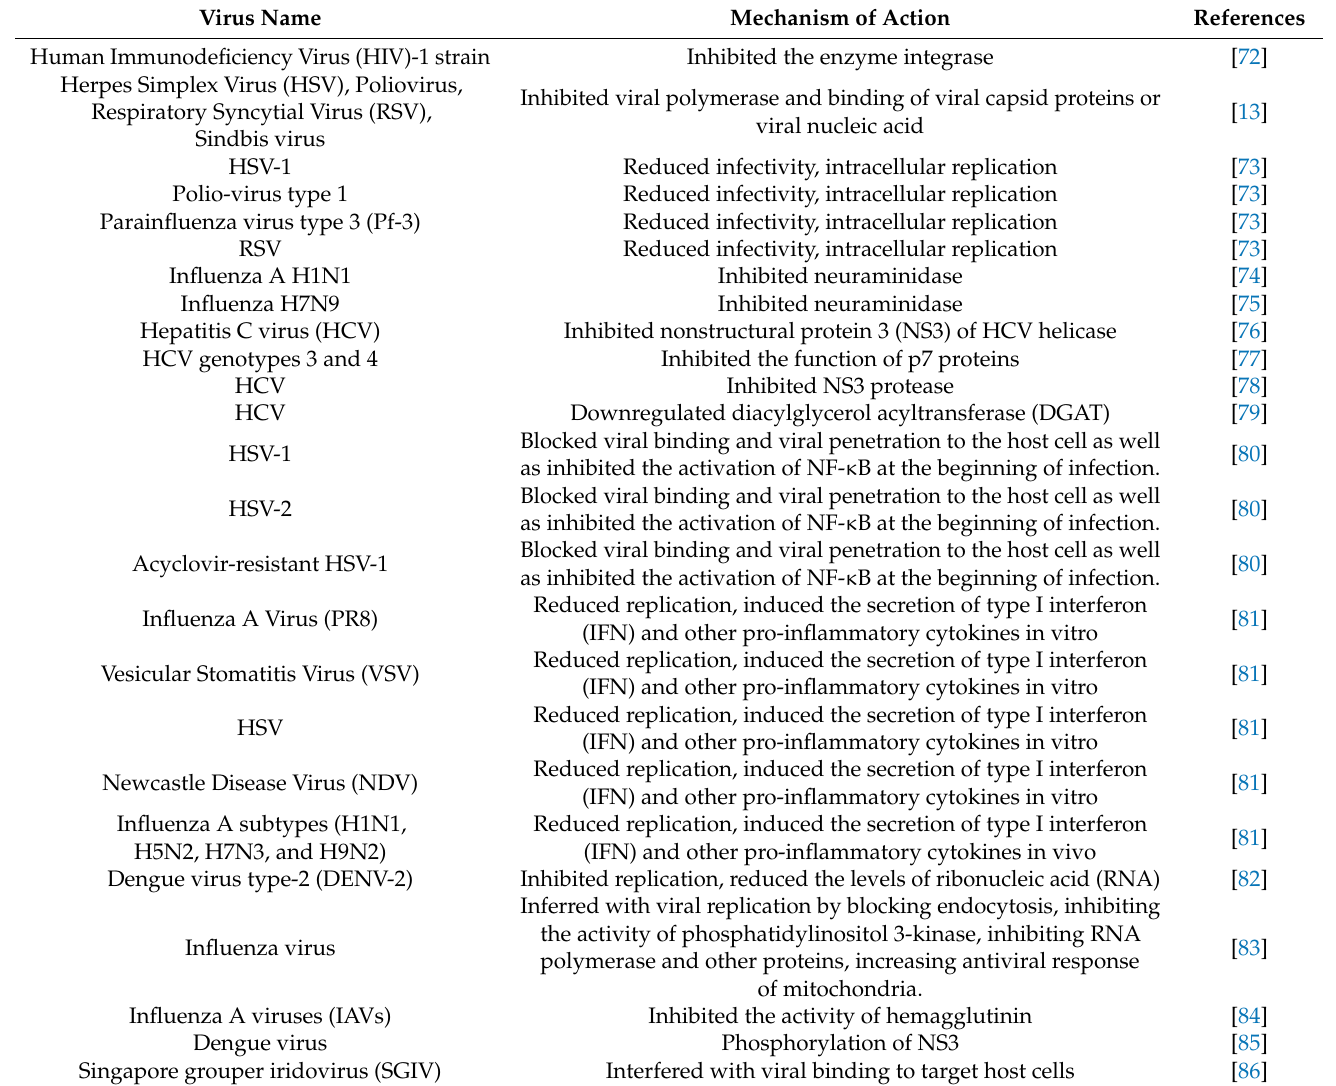
Table 2. Antiviral mechanism of